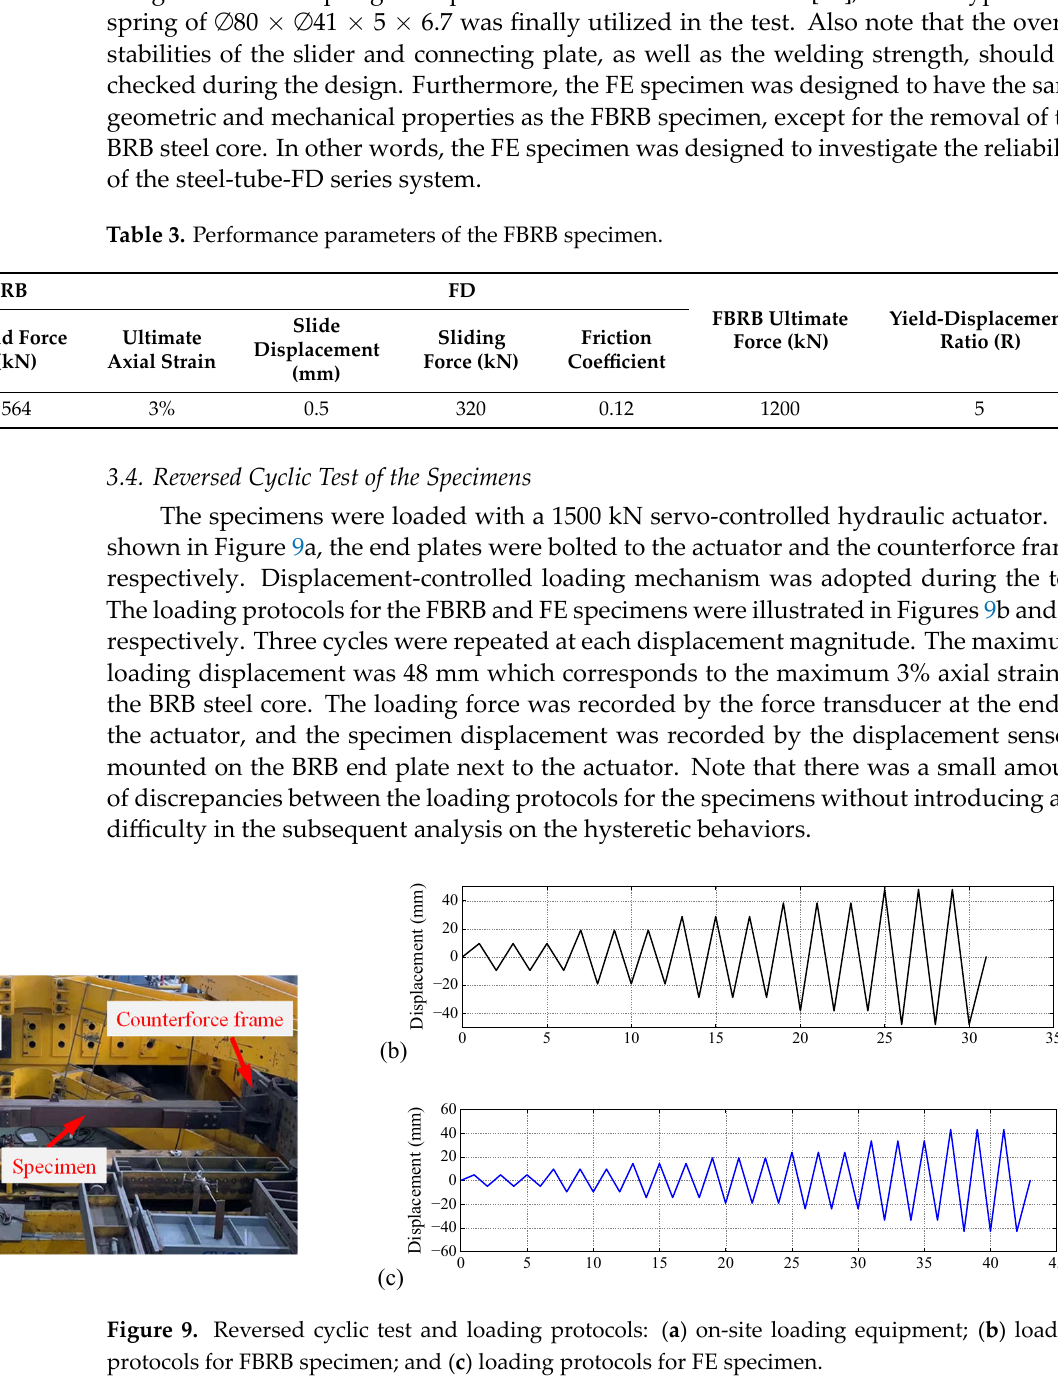
Table 3. Performance parameters of the FBRB specimen.